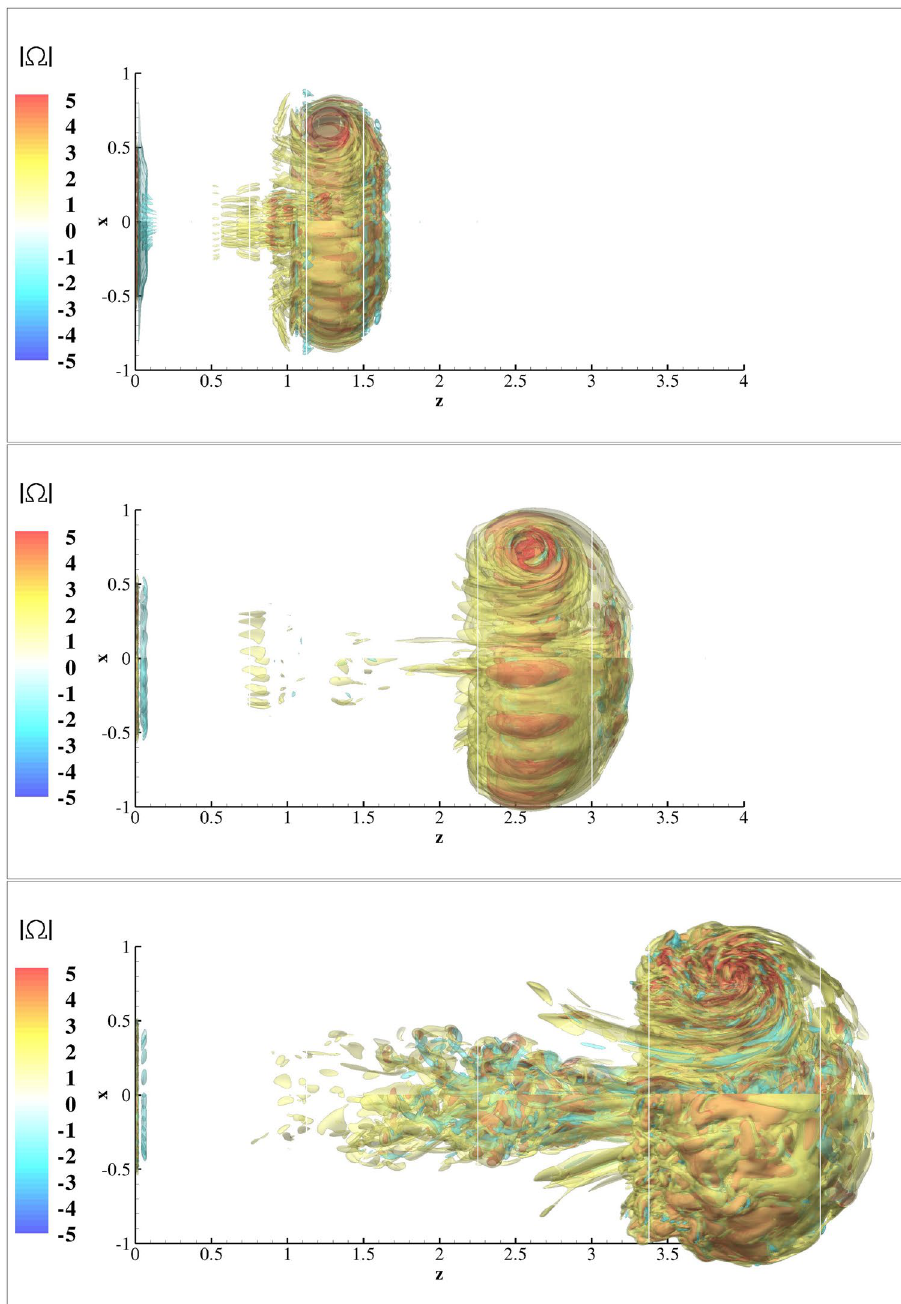
2 0 / L for the test cases 3 s equal